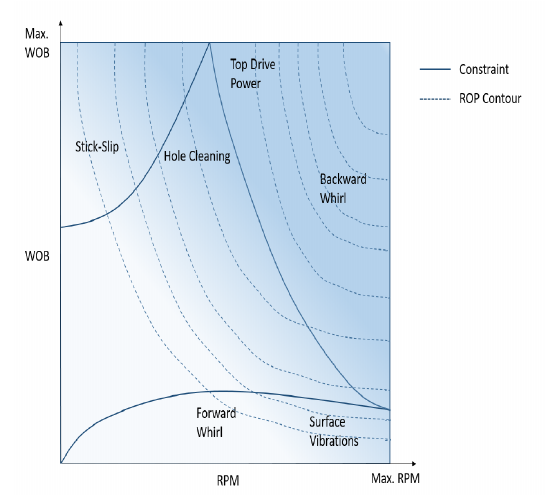
Figure 3: Constraints and ROP contours in the state space of the drilling